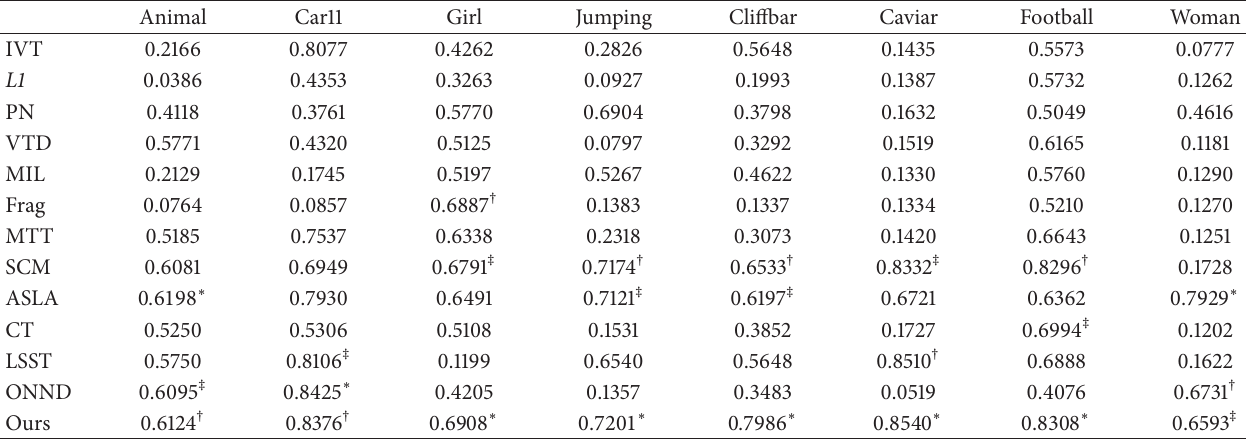
Table 3: Average tracking success rate. The best three results are marked by ∗ , † , and ‡ . Animal Car11 Girl Jumping Cliffbar Caviar Football